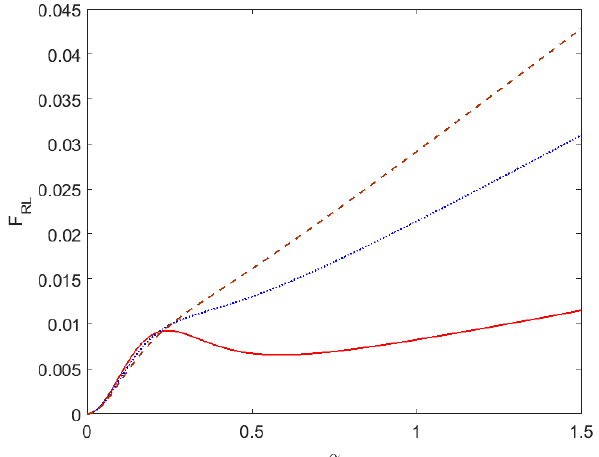
Figure 7. Stark–Lorentz absorption probability F RL for Rydberg radiative transitions in H-atoms as a function of pulse duration parameter α , detuning parameter δ = 5 and different ratios of impact collision to static widths: solid line − γ = 0, dotted line − γ = 1, dashed line − γ = 2. The same procedure can be done with account for Stark–Doppler broadening: